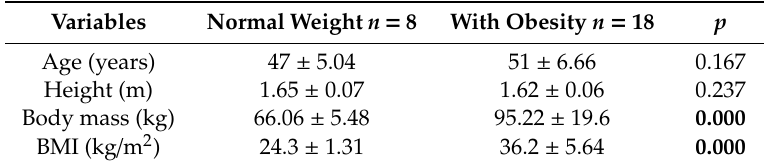
Table 1. Characteristics of the study groups before the